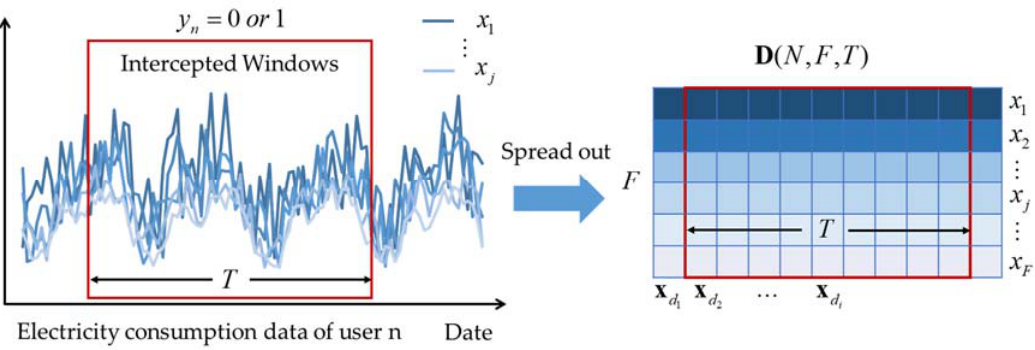
Figure 2. Two-dimensional data structure of electricity consumption Figure 2. Two ‐ dimensional data structure of electricity consumption data.